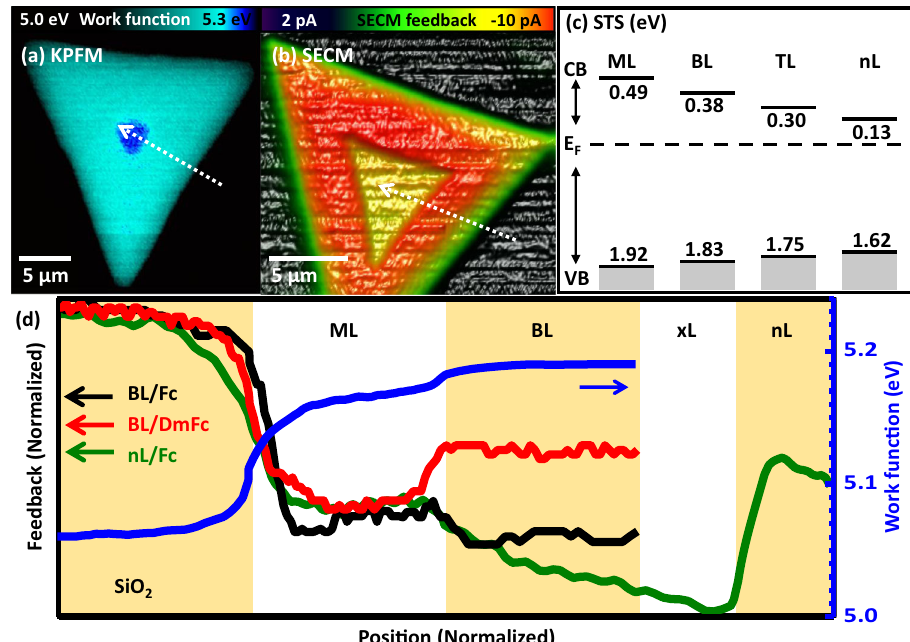
Fig. 4 Layer dependent physical properties of MoS 2 . a Local variation of the work function as recorded in KPFM. (Scan rate: 20 µ m/s) and b SECM feedback for a bilayer within a monolayer MoS 2 fl ake. (Scan rate: 20 µ m/s, V WE-RE (Ag) : 0.2 V, DmFc mediator). c Band gap and conduction band onset for MoS 2 of different thicknesses relative to the Fermi Energy E F (dashed line) as obtained in STS. (Setpoint: 1.5 V, 49 pA). d Combined cross-sectional data from KPFM (blue, from a ), SECM feedback with Fc mediator (black, from Fig. 3d), with DmFc mediator (red, from b ) and SECM feedback with Fc mediator of a thick MoS 2 fl ake (green). Data are normalized to the intensity on the monolayer for relative comparison. Data from the thick fl ake of approx. nL = 8-layers begin on the SiO 2 substrate with, in AFM clearly resolved monolayer and bilayer areas, succeeded by a narrow transition (xL) region from second layer to a fl at and extended n-layer plateau. Within the transition region, SECM data cannot be attributed to individual layers but are respectively resolution limited. TL = triple layer, CB = conduction band onset, VB = valence band onset. Background color variations indicate change of layer